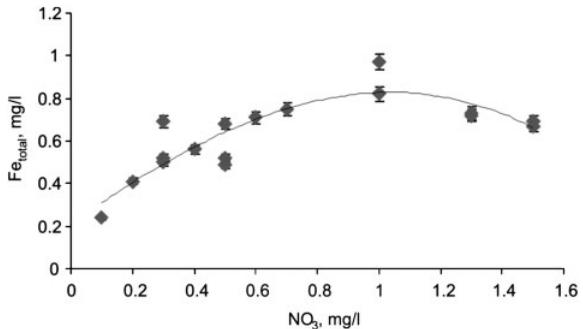
Fig. 4. Dependency between nitrate and total iron concen- trations in Vilnius network sampling points